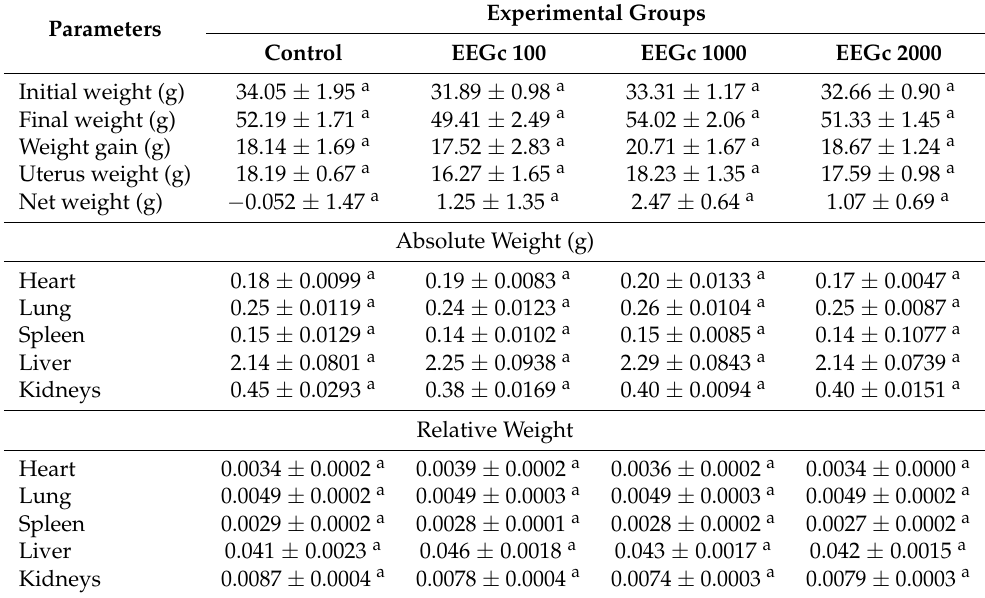
Table 1. Biometric parameters, absolute weight, and relative weight of the organs of females treated with the ethanolic extract of G. celosioides